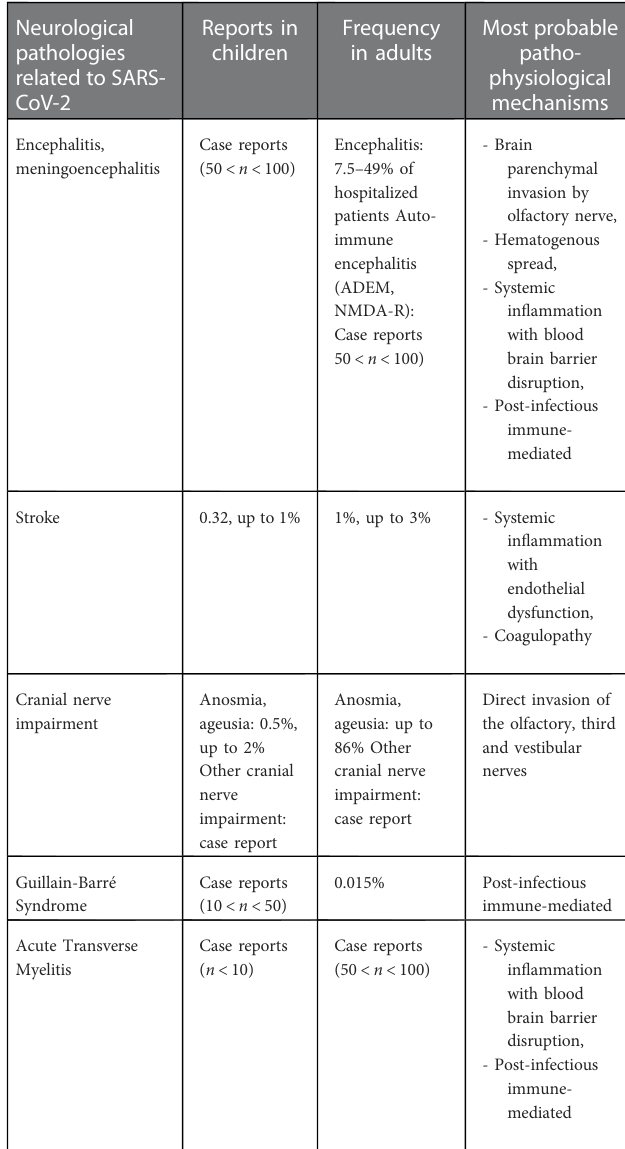
TABLE 2 Summary of frequencies of neurological pathologies related to SARS-CoV-2 in children and in adults, and most probable pathophysiological